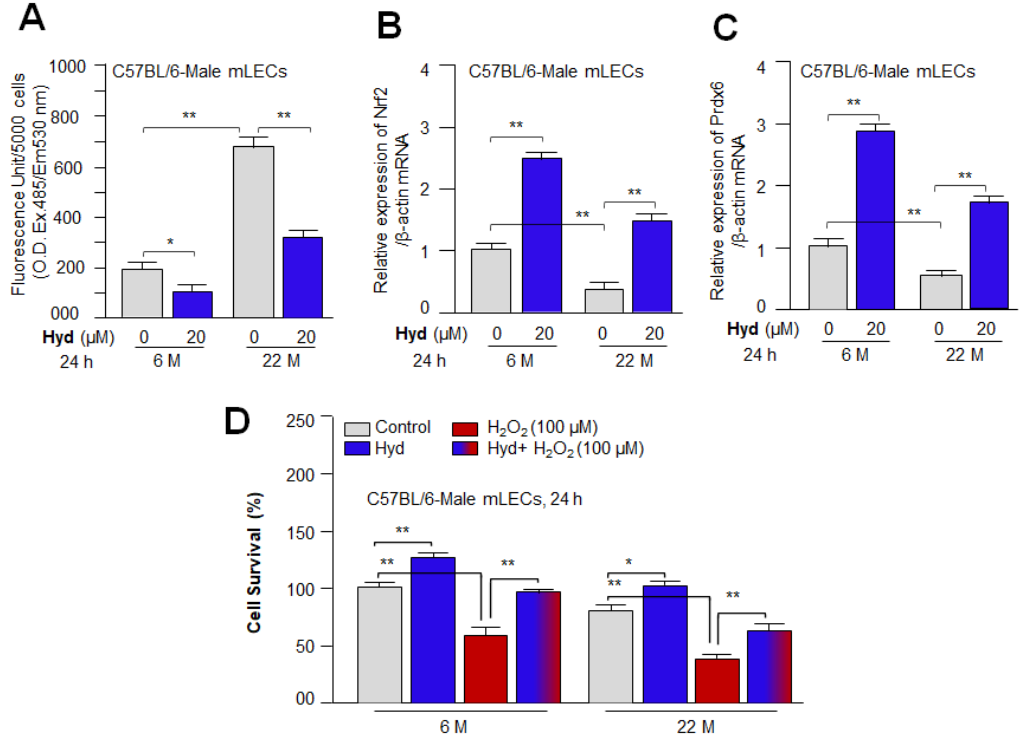
Figure 9. As observed in hLECs, Hyd rescued aging mLECs against oxidative stress via Nrf2-activation/reactivation antioxidant pathway. ( A ) Primary mLECs isolated from different age groups of C57BL/6 mice were cultured in 96-well plates and treated with Hyd for 24 h. Increased ROS during aging was alleviated by Hyd treatment. ROS levels were measured using H 2 -DCF-DA dye methods. The histogram data represent the mean ± S.D. value from three independent experiments. * p < 0.05; ** p < 0.001. ( B , C ) Primary mLECs isolated from 6 M and 22 M old C57BL/6 male mice were treated with Hyd for 24 h. Total RNA isolated from Hyd-treated primary mLECs was subjected for transcript analysis of Nrf2 and its target gene Prdx6 with specific primer sequences as shown in Table 1. All histograms represent the mean ± S.D. values from three independent experiments. ** p < 0.001. ( D ) Hyd was efficacious in defending both younger and aged mLECs from H 2 O 2 -induced cellular damage. Hyd treated or untreated primary mLECs were exposed to H 2 O 2 , and cell viability was assessed after 24 h. The histogram data represent the mean ± S.D. values from three independent experiments. * p < 0.05; ** p <